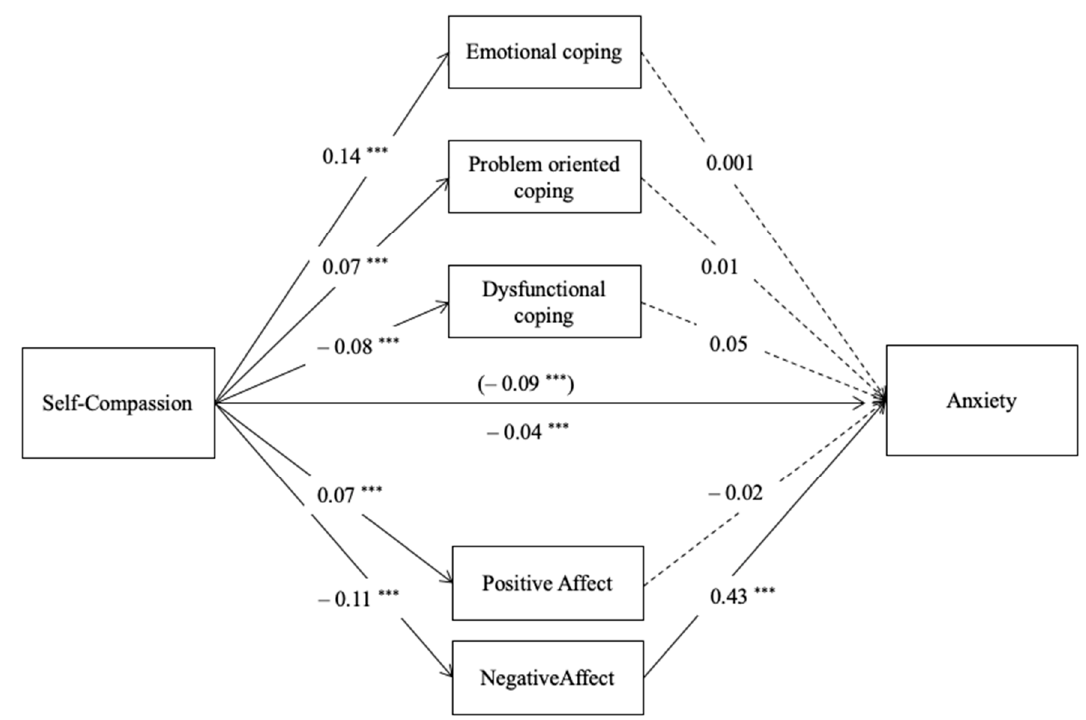
Figure 2. Parallel mediation model with path coefficients (unstandardized): self-compassion, positive affect, negative affect, emotional coping, problem-oriented coping, dysfunctional coping, and anxiety (M2). Note: *** p < 0.001, c’ (direct effect) above the line and c (total effect) below the line, dashed lines are not-significant paths.